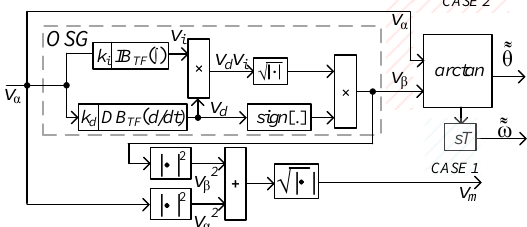
Figure 8. Proposed wide band frequency detection system.